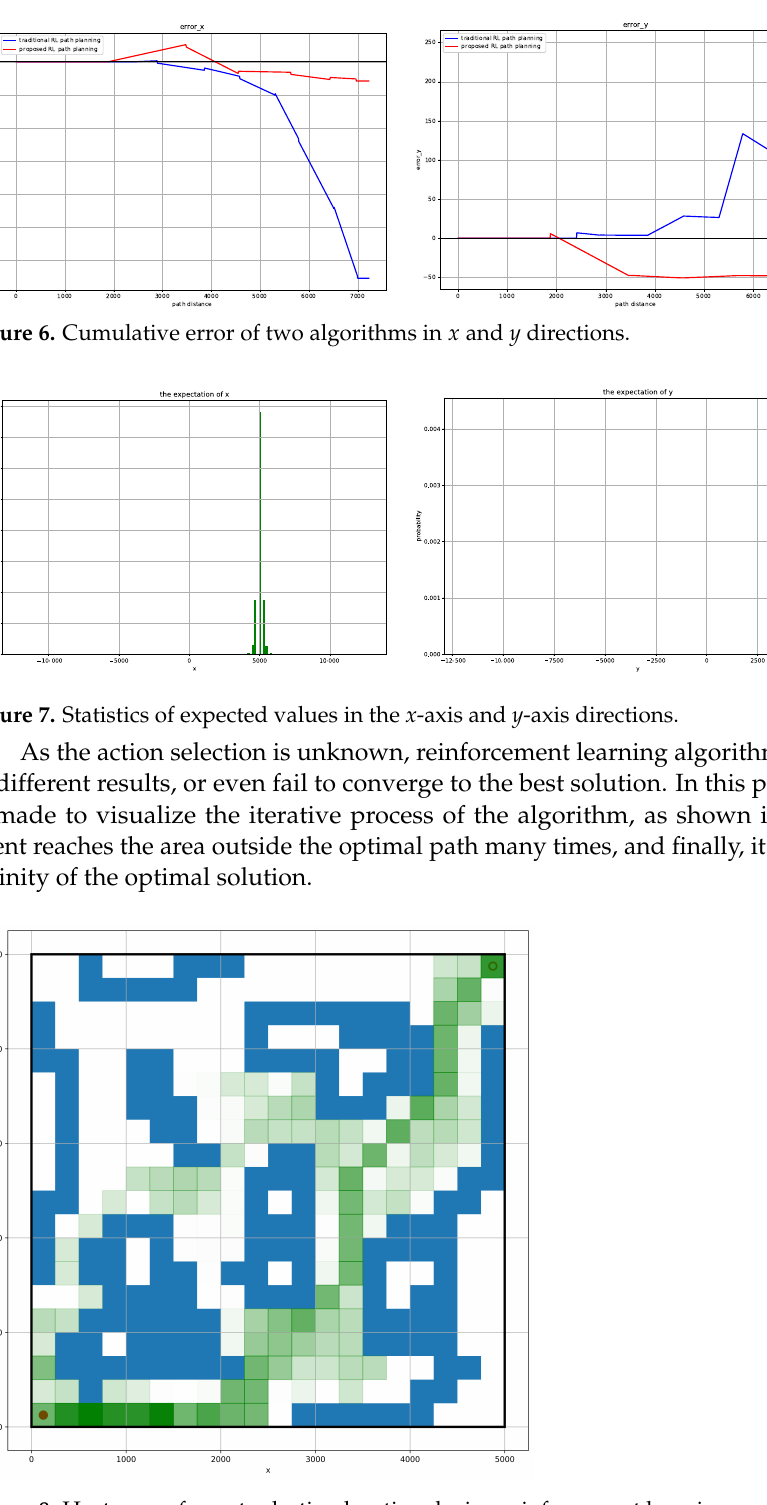
Figure 8. Heat map of agent selection location during reinforcement